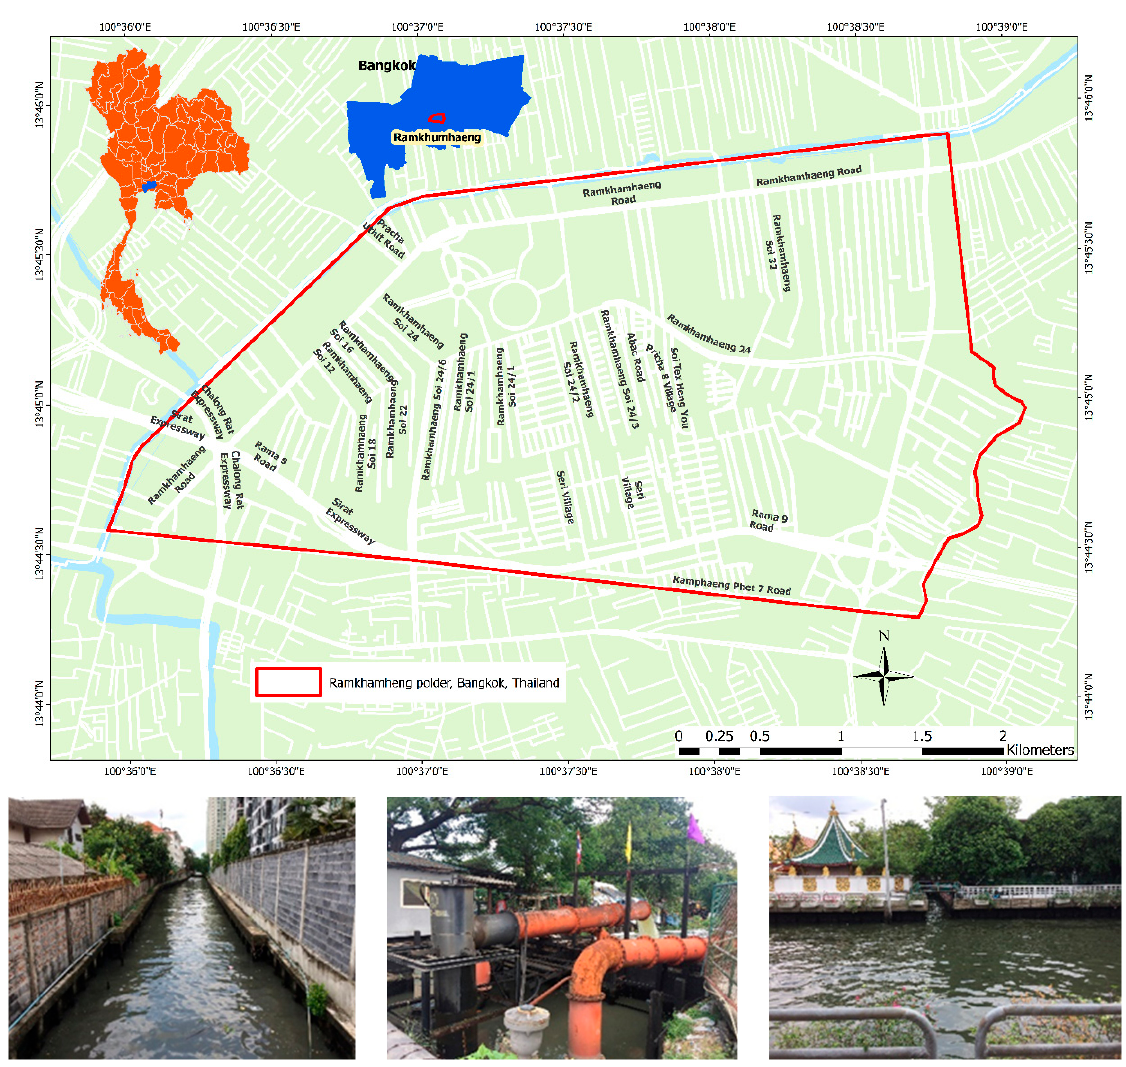
Figure 1. Top . Map of the Ramkhamhaeng polder, Bangkok, Thailand. The Ramkhamhaeng polder is one of Bangkok’s water management polder systems [51]. Additionally, shown (bottom photographs) are the typologies of the drainage system illustrating its distinct characteristics from those of the Global North. Bottom left: A secondary canal within the study area. Bottom middle: Pumping water from the central region of the study area towards the primary canal system. Bottom right: The primary canal, Saen Seab, is in the foreground, with the mouth of a secondary canal visible to the right of the temple area (photos by authors).